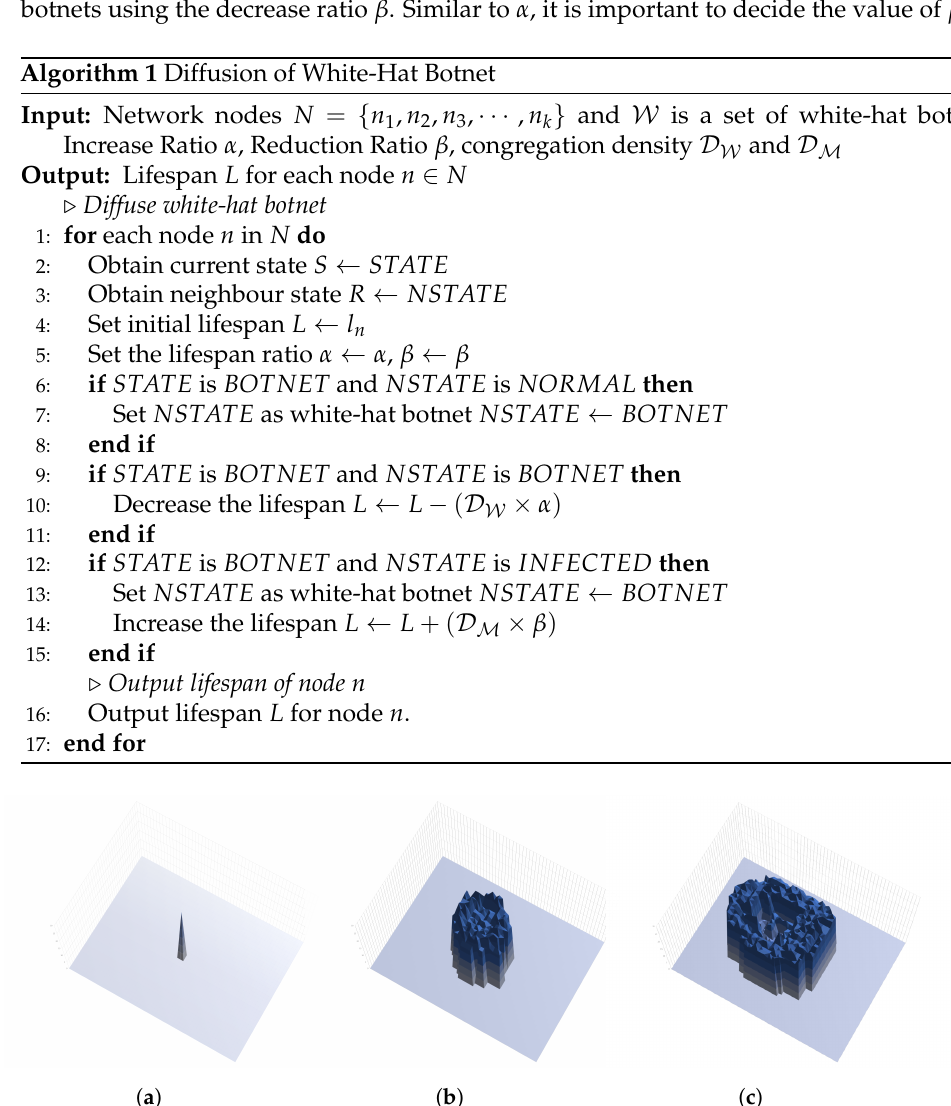
Figure 5. Image of the ripple effect. The height of the surface graph shows the remaining age. ( a ) Initial placement of white-hat botnet ( t = 1). ( b ) The rise of ripple effect ( t = 20). ( c ) The expansion of ripple effect ( t =